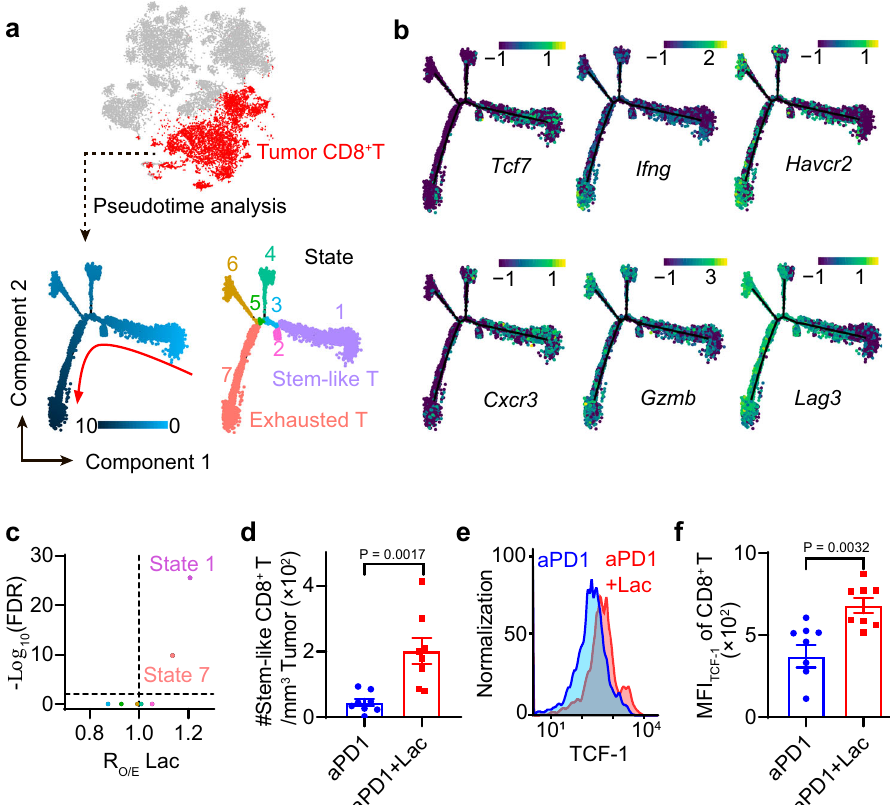
Fig. 4 | Lactate treatment increases stem-like CD8 + T cell population in MC38 tumors. a Pseudotime trajectory of CD8 + T cells in tumors identi fi es the differ- entiation process and distinct states of CD8 + T cell subtypes. b Labeling of top marker genes on pseudotime trajectory identi fi es the cells in state 1 are stem-like T cellswhilethose in state 7 are exhausted T cells. c Changeof CD8 + T cellfraction with aPD1+Lac verses aPD1 treatment. R O/E Lac analysis showed lactate treatment increased the T cell populations in states 1 and 7. d Validation of increase in TCF1 + PD1 + CD8 + T cell population after lactate treatment by fl ow cytometry. C57BL/6